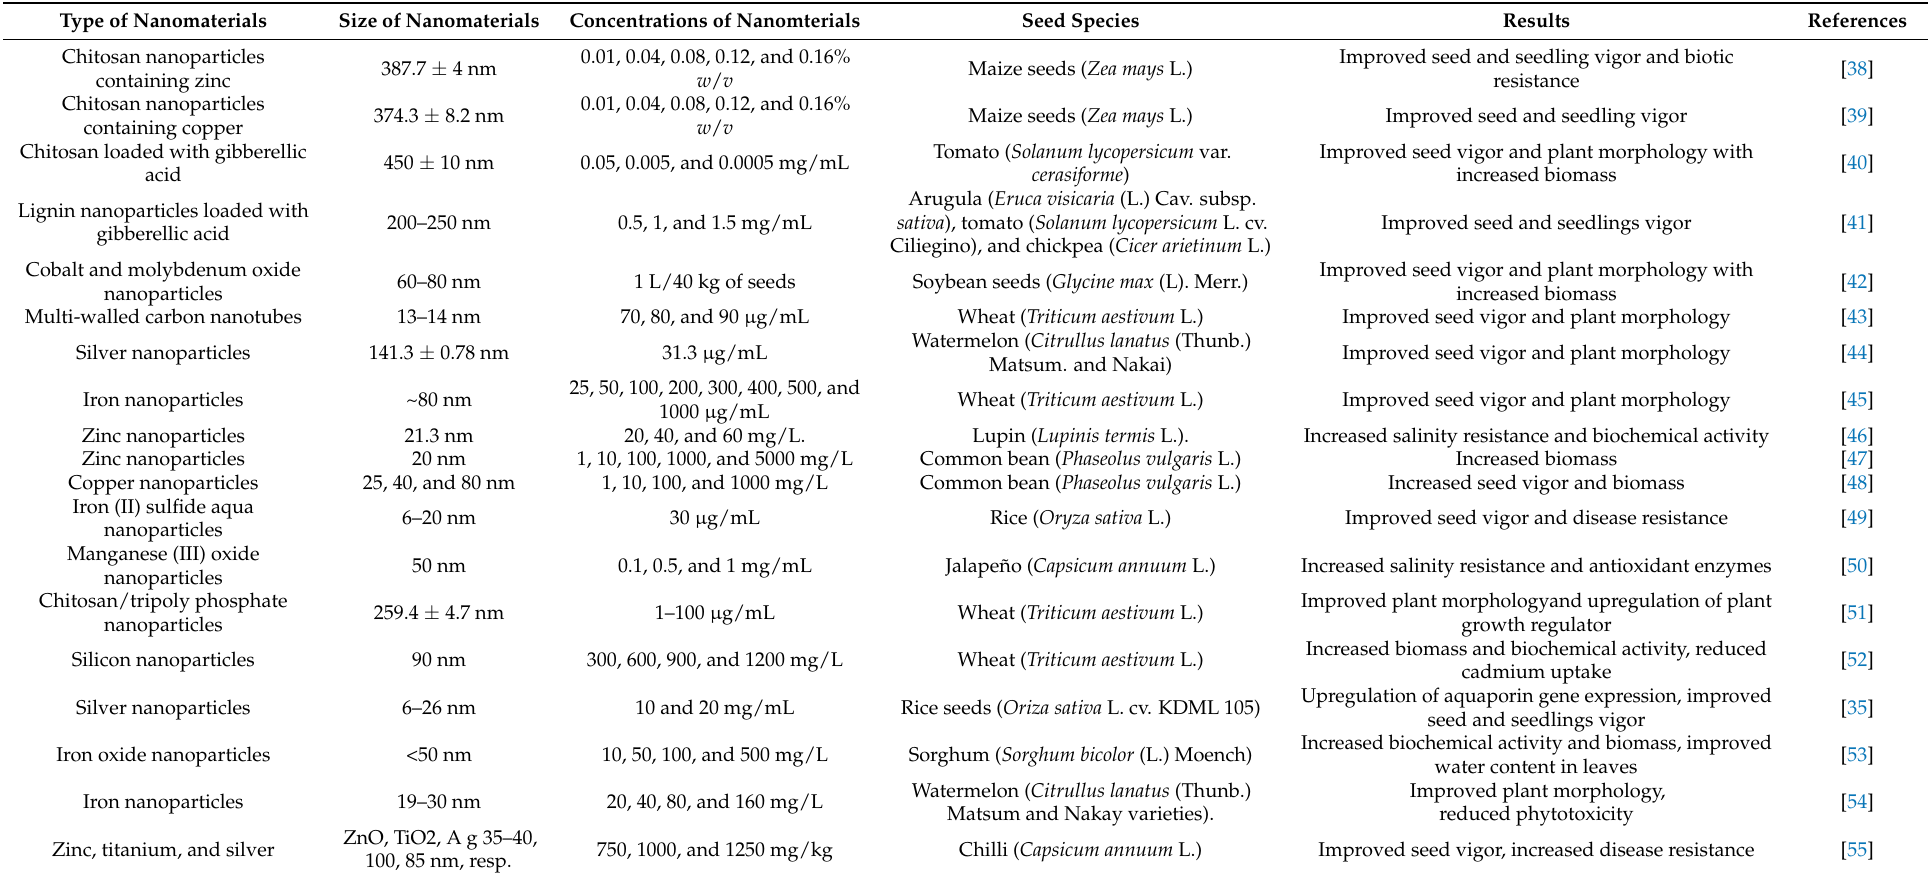
Table 1. An overview of nanoparticles used for seed priming, their physico-chemical properties, and the main effects on some species of seeds when evaluated against biotic and abiotic stress